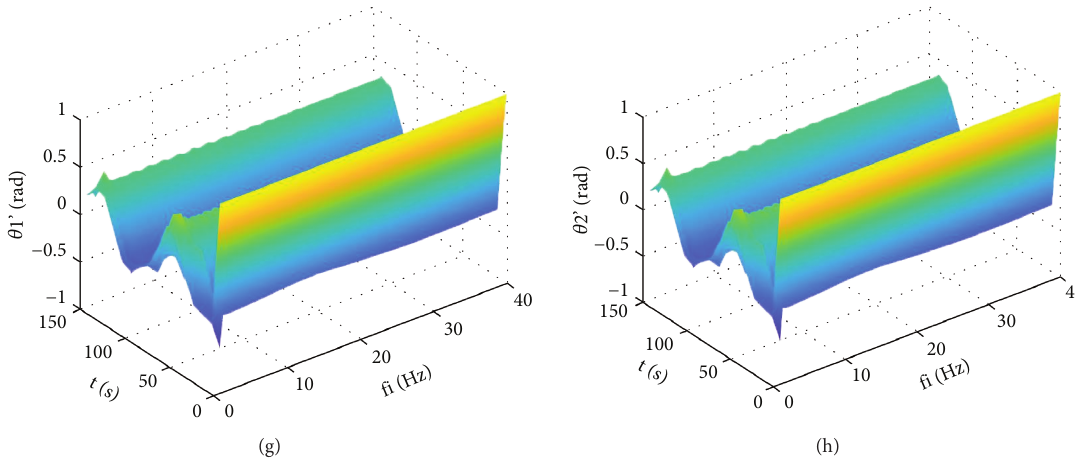
Figure 8: Surface diagrams of z ′ , and θ ′ changing with f q , z 7 , z 6 , θ 1 , θ 2 , θ 3 , θ 1 i during continuous time. (a) The surface diagram of z q changing 2 with f i . (b) The surface diagram of z 7 changing with f i . (c) The surface diagram of z 6 changing with f i . (d) The surface diagram of θ 1 changing with f i . (e) The surface diagram of θ 2 changing with f i . (f) The surface diagram of θ 3 changing with f i . (g) The surface diagram of θ ′ changing with f with f i . (h) The surface diagram of θ i . 2